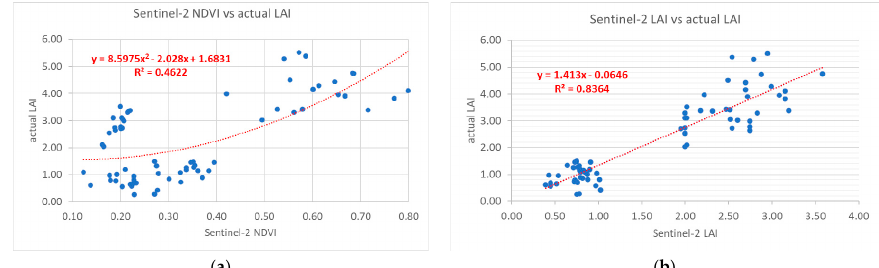
Figure 12. Performance of LAI estimation using ( a ) Sentinel–2’s NDVI product and ( b ) Sentinel–2’s LAI